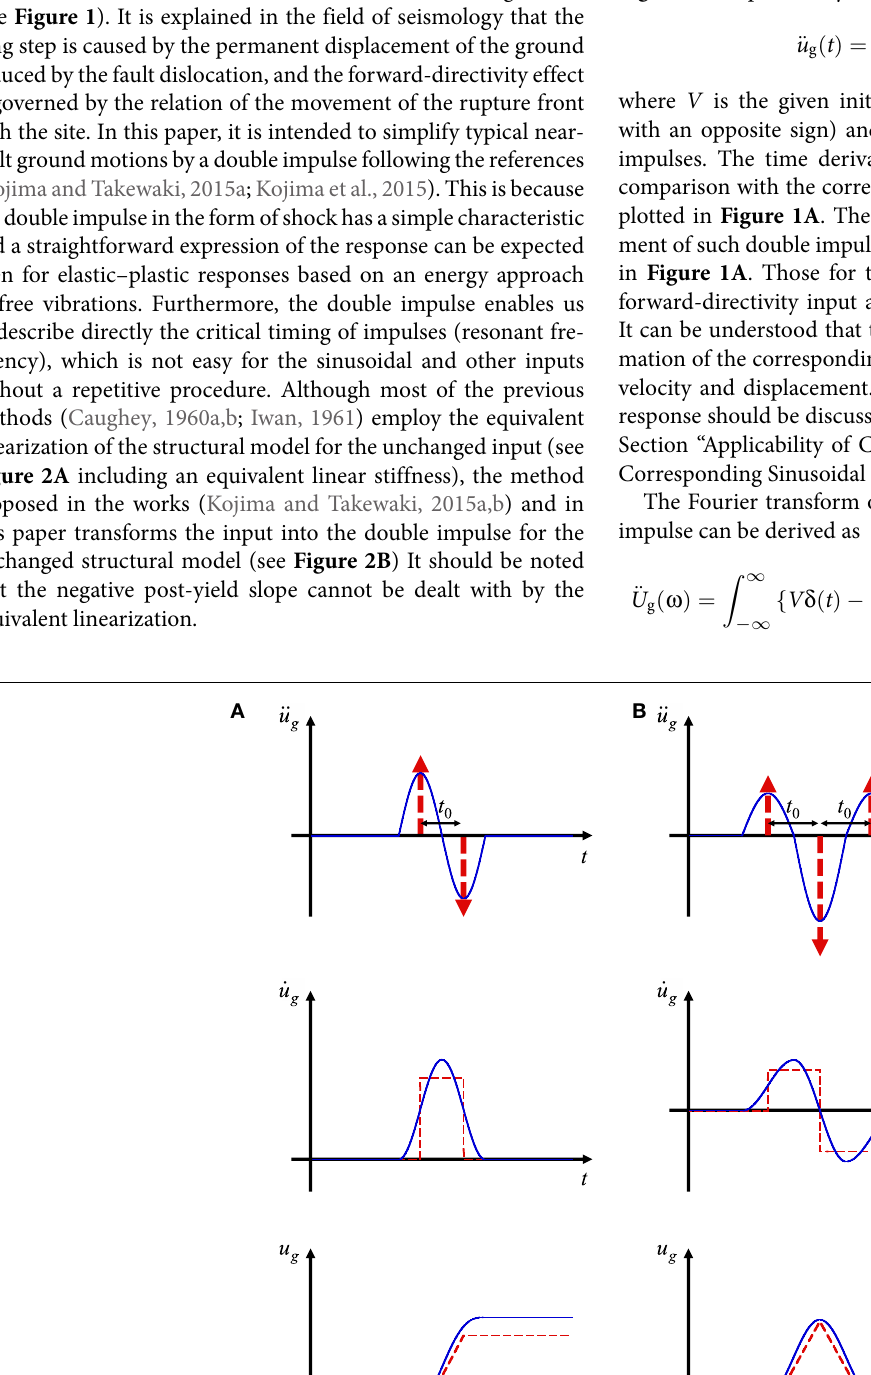
Frontiers in Built Environment |